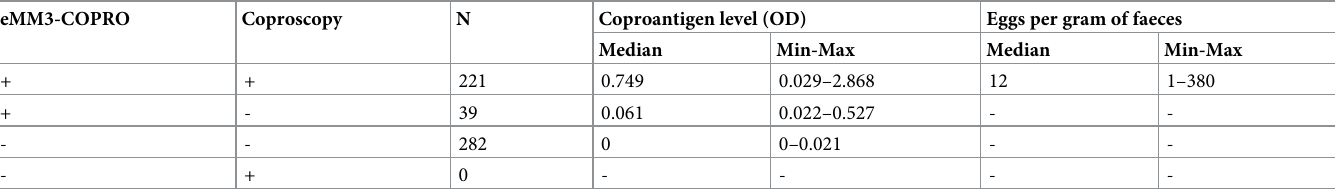
Each sample (n = 542) was simultaneously analyzed by the eMM3-COPRO test and coproscopy. In the eMM3-COPRO test, a sample was considered positive when it yielded an optical density value (OD) above the cut-off (OD = 0.021). Coproscopy included counting Fasciola eggs (with a sensitivity of 1 egg per gram of faeces).